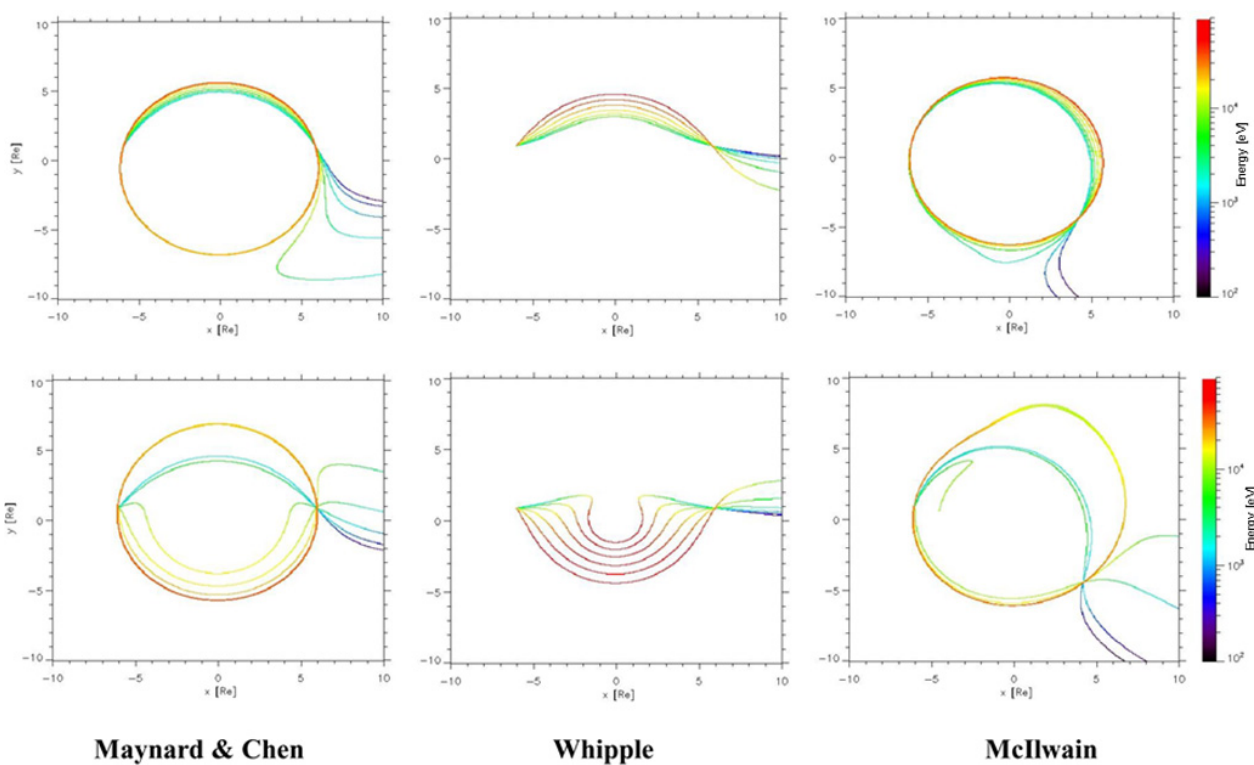
Fig. 3. Electron (top panel) and proton (bottom panel) trajectories back-in-time from the point ( − 6,1) in the equatorial plane with the Maynard and Chen, Whipple and McIlwain models ( µ ={ 7 . 2 × 10 6 ; 1 . 4 × 10 7 ; 2 . 9 × 10 7 ; 5 . 7 × 10 7 ; 1 . 2 × 10 8 ; 2 . 3 × 10 8 } keV/T for E 0 ={ 1; 2; 4; 8; 16; 32 } keV at Kp =